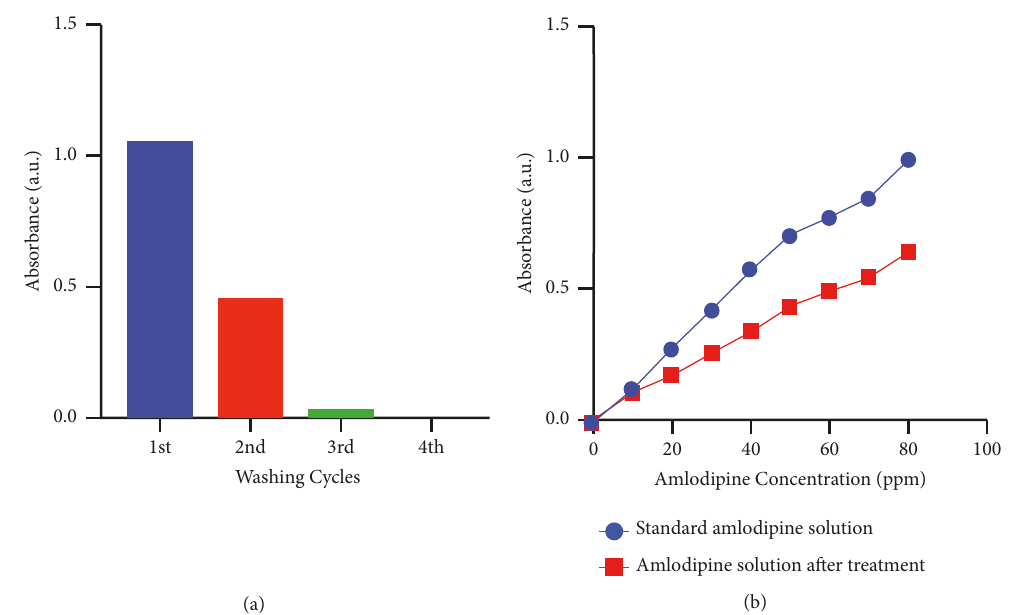
Figure 3: (a) The decreasing absorbance of amlodipine on successive washings confirms the removal of template molecules from the MIP- silica hybrid particles, whereas (b) shows the absorbance of standard amlodipine solutions (concentration: 10-80 ppm) decreasing after treatment with the hybrid